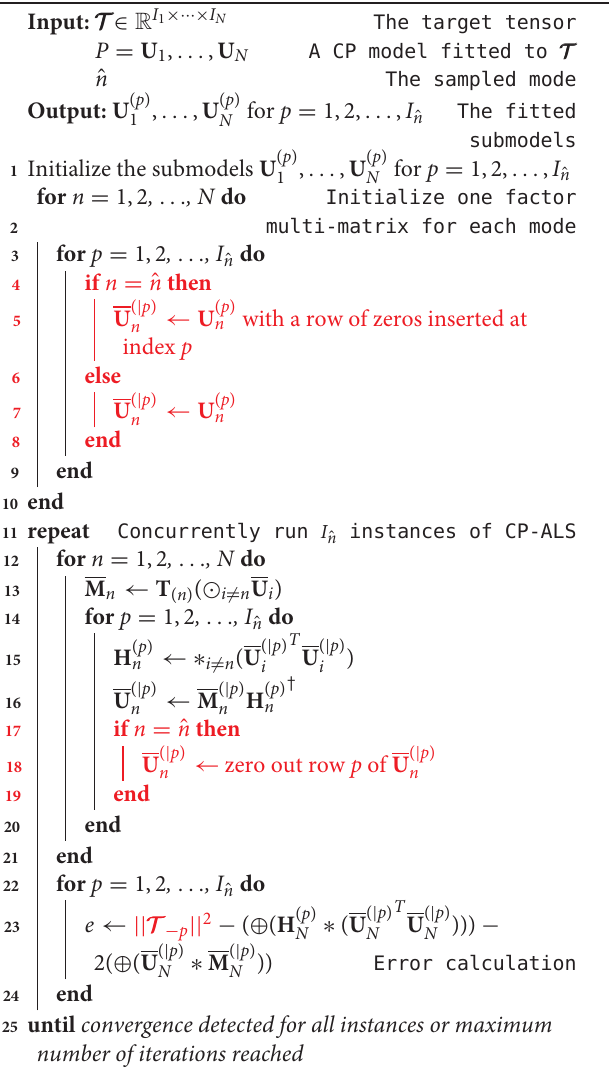
Algorithm 2: JK-ALS: An algorithm that performs (LOO) jackknife resampling on a CP model.